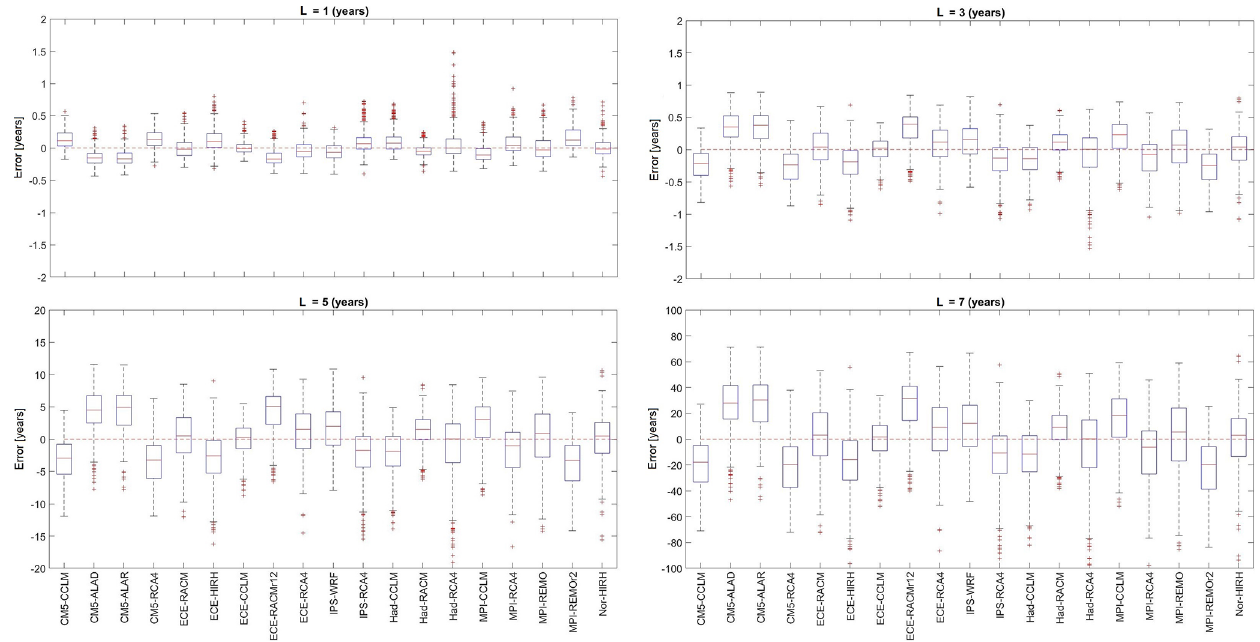
Figure 12. Box plots representing the frequency distribution of RCM errors in the return period of drought events of duration L equal to 1, 3, 5, and 7 years.